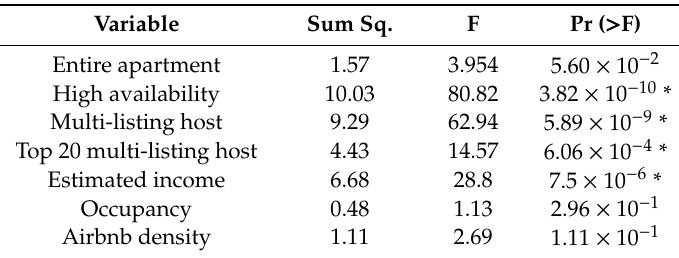
Table 4. One-way ANOVA. Variable Sum